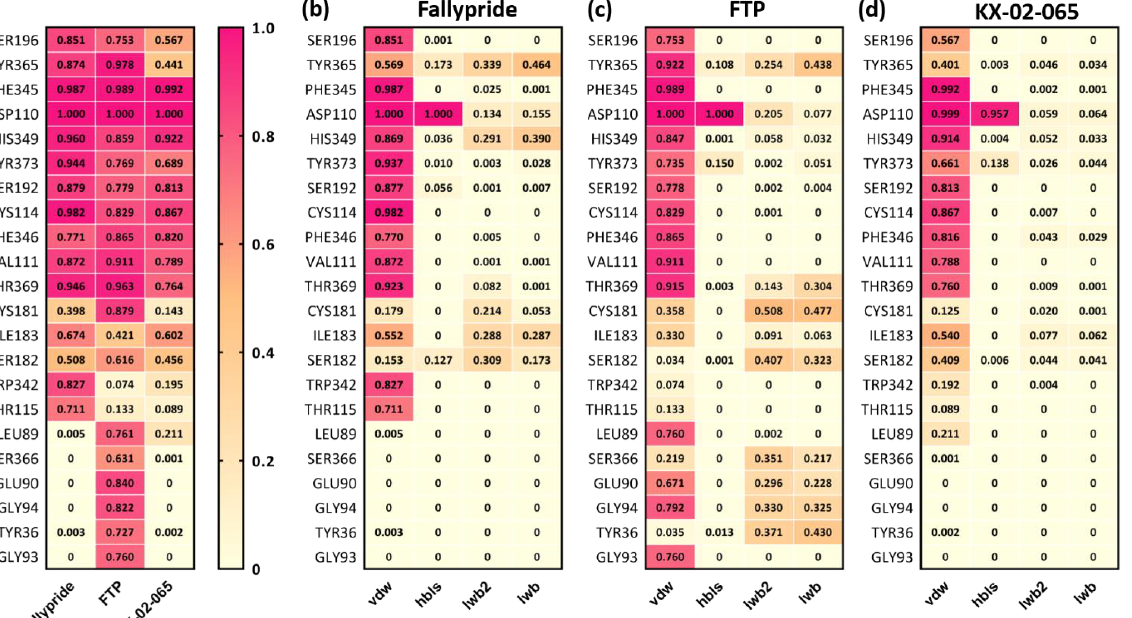
Table 1. Summary of MM/GBSA binding free energy (kcal/mol).